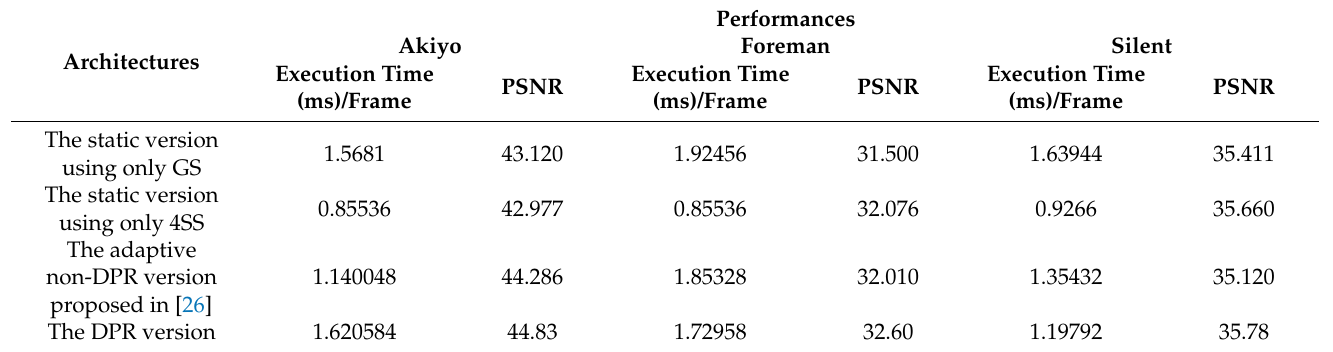
Table 3. Comparison between the static and reconfigurable watermarking systems in terms of